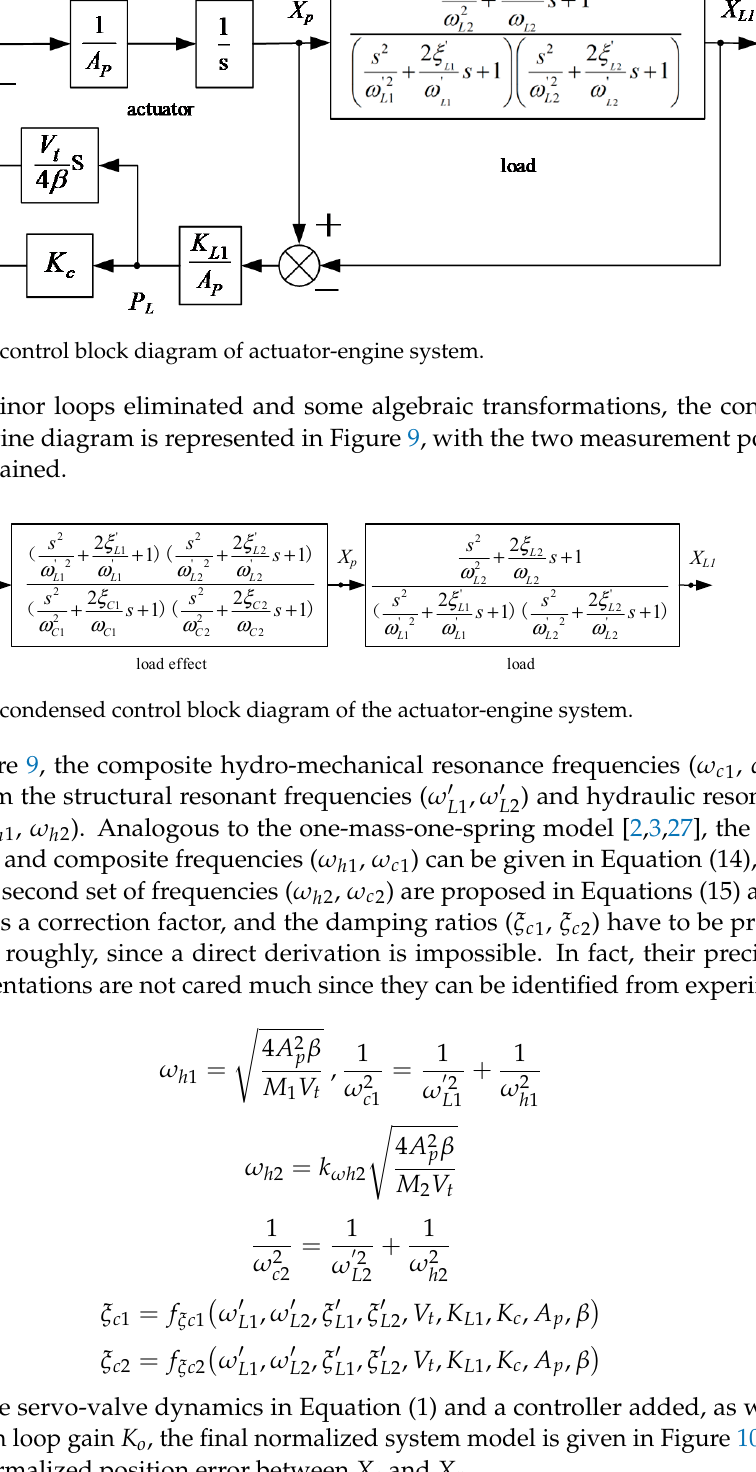
Figure 10. A normalized block diagram of the aerospace electro-hydraulic actuation system. The open-loop K o is represented in Equation (19). 𝐾 (cid:3042) = 𝐾 (cid:3043) 𝐾 (cid:3049)(cid:3036) 𝐾 (cid:3044)(cid:3036) 𝐾 (cid:3051)(cid:3033) 𝐴 (cid:3043) (19) where K p is the nominal error amplification gain, K vi is the lumped voltage-to-ampere con- version coefficient of the digital-to-analog (D/A) converter and the servo-valve coil driver, K xf is the lumped conversion coefficient of the analog-to-digital (A/D) converter and the feedback displacement sensor.